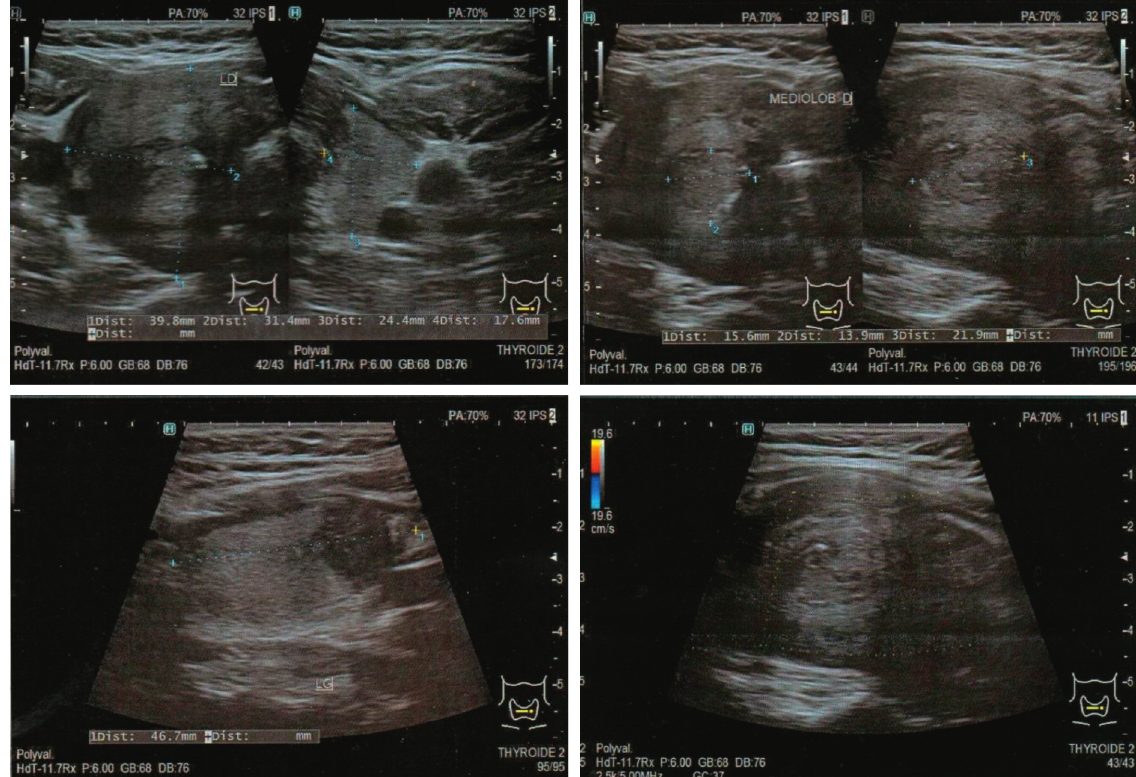
Figure 1: Patient’s cervical ultrasound showing a hypovascularized nodular